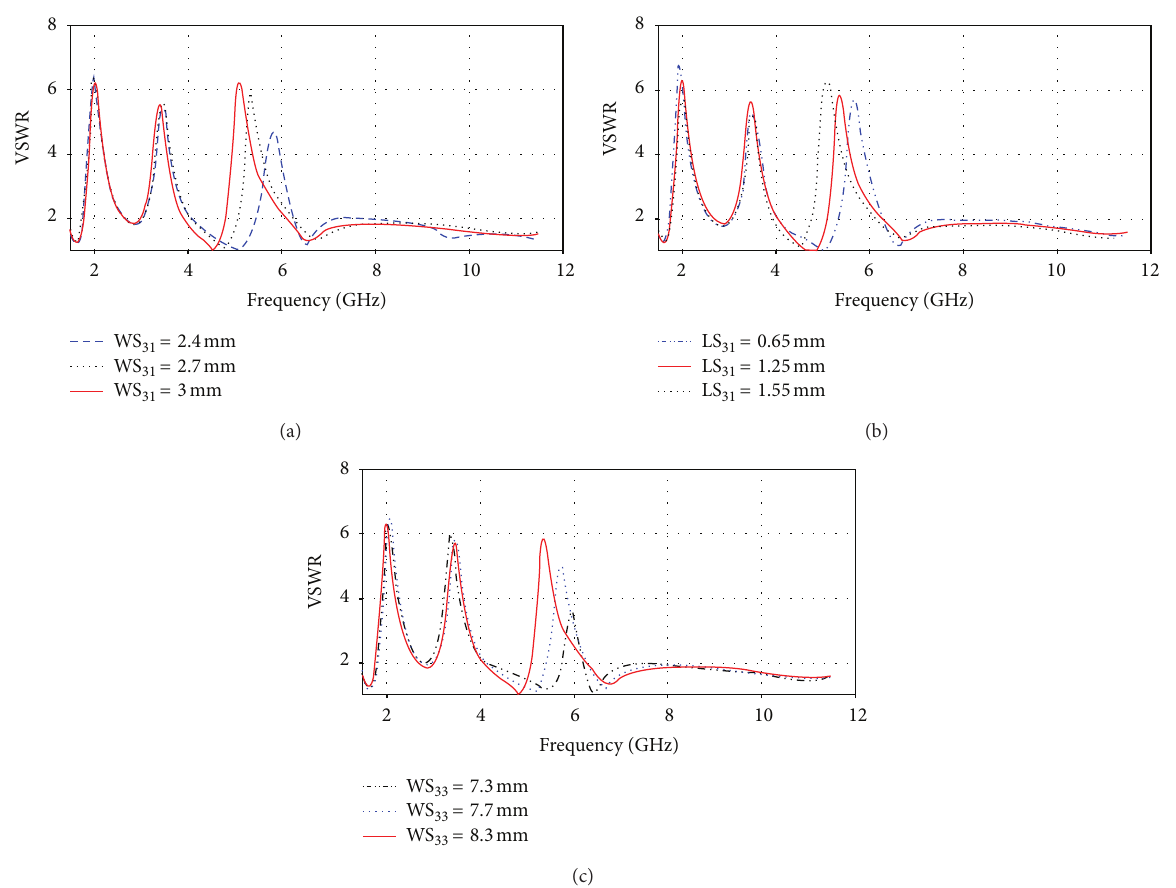
Figure 7: The simulated VSWR of the proposed antenna: effects of some parameters on the 5.68 GHz band-notched function, (a) WS 31 , (b) LS 31 , (c) WS 33 .